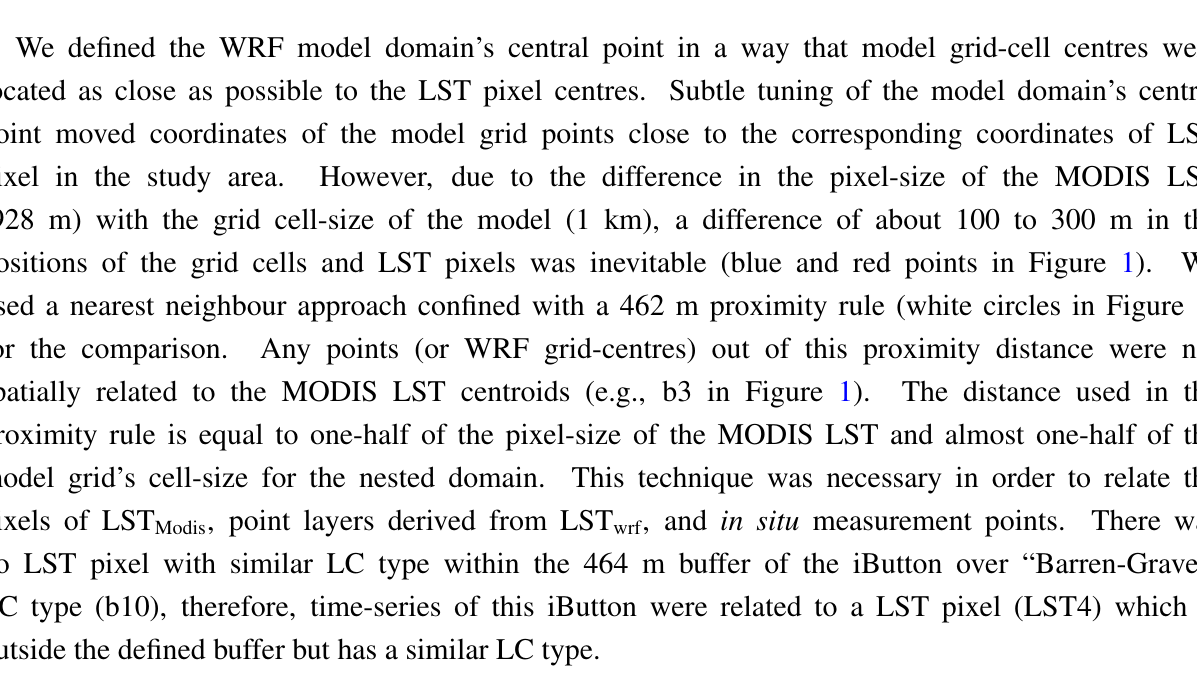
= LST1, LST4, etc .) and endmembers ( s i